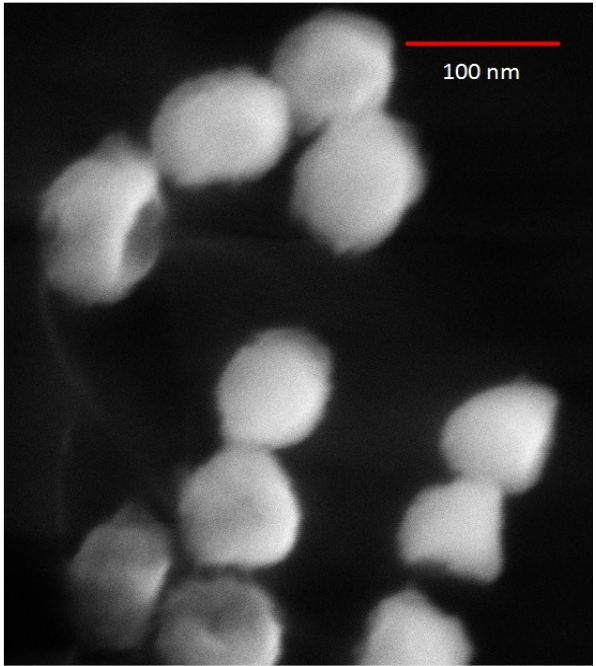
Fig. 4. Scanning electron micrograph of the biosynthesized AgNPs